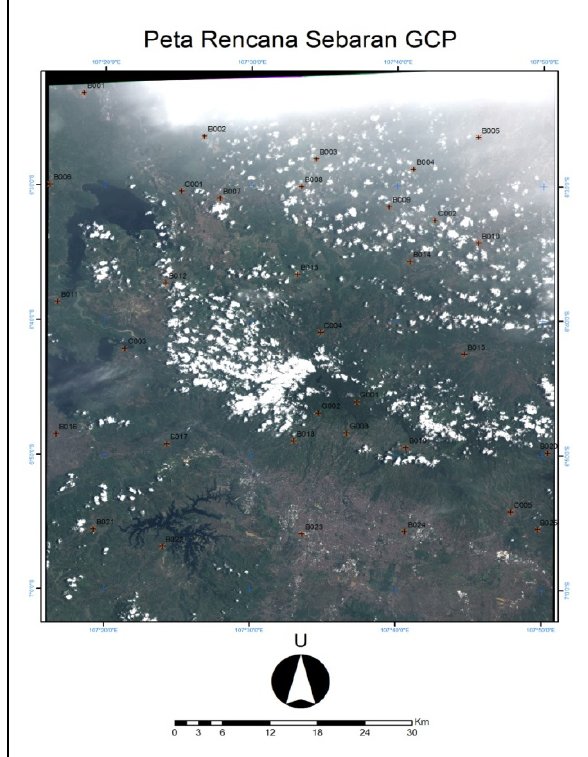
Figure 5. GCPs from GNSS Survey